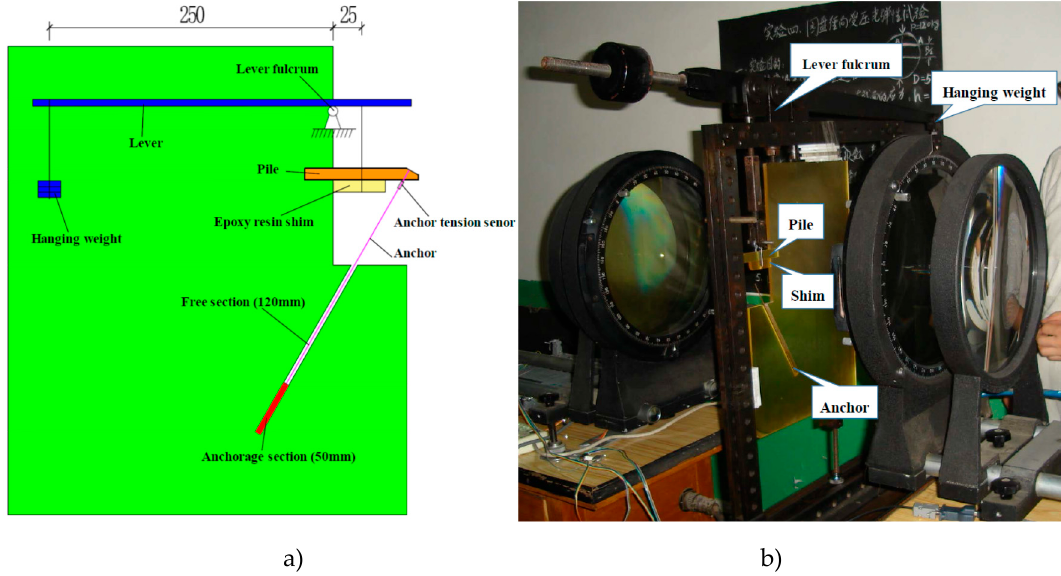
Figure 3. Loading design structure. ( a ) Schematic of loading design structure, ( b ) physical photo of loading design structure.